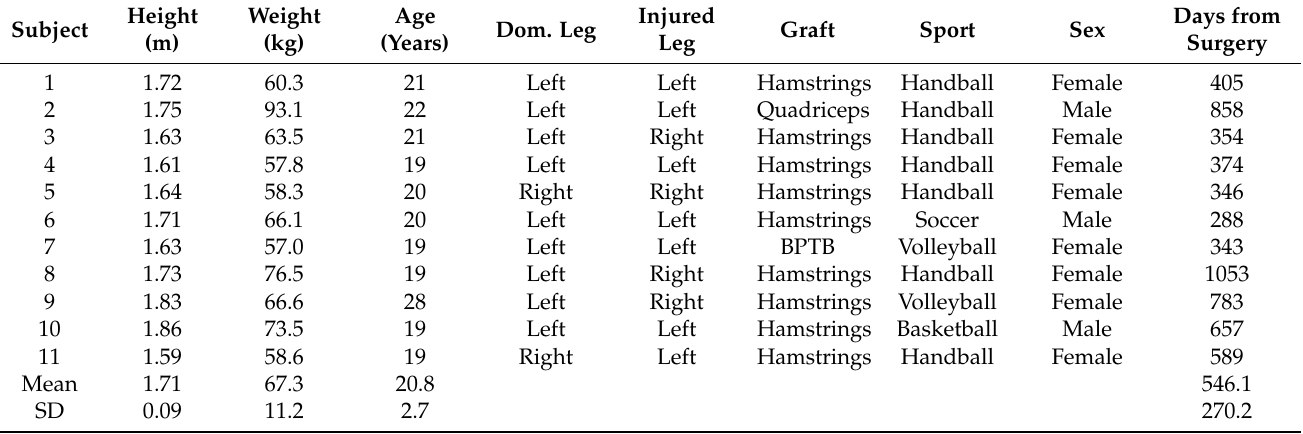
Table 1. Participant information. Dom. Leg: Dominant leg, take-off leg for one-legged jump; BPTB: Bone-patellar tendon-bone; SD: Standard deviation. Days from surgery are counted until the day of pre-intervention